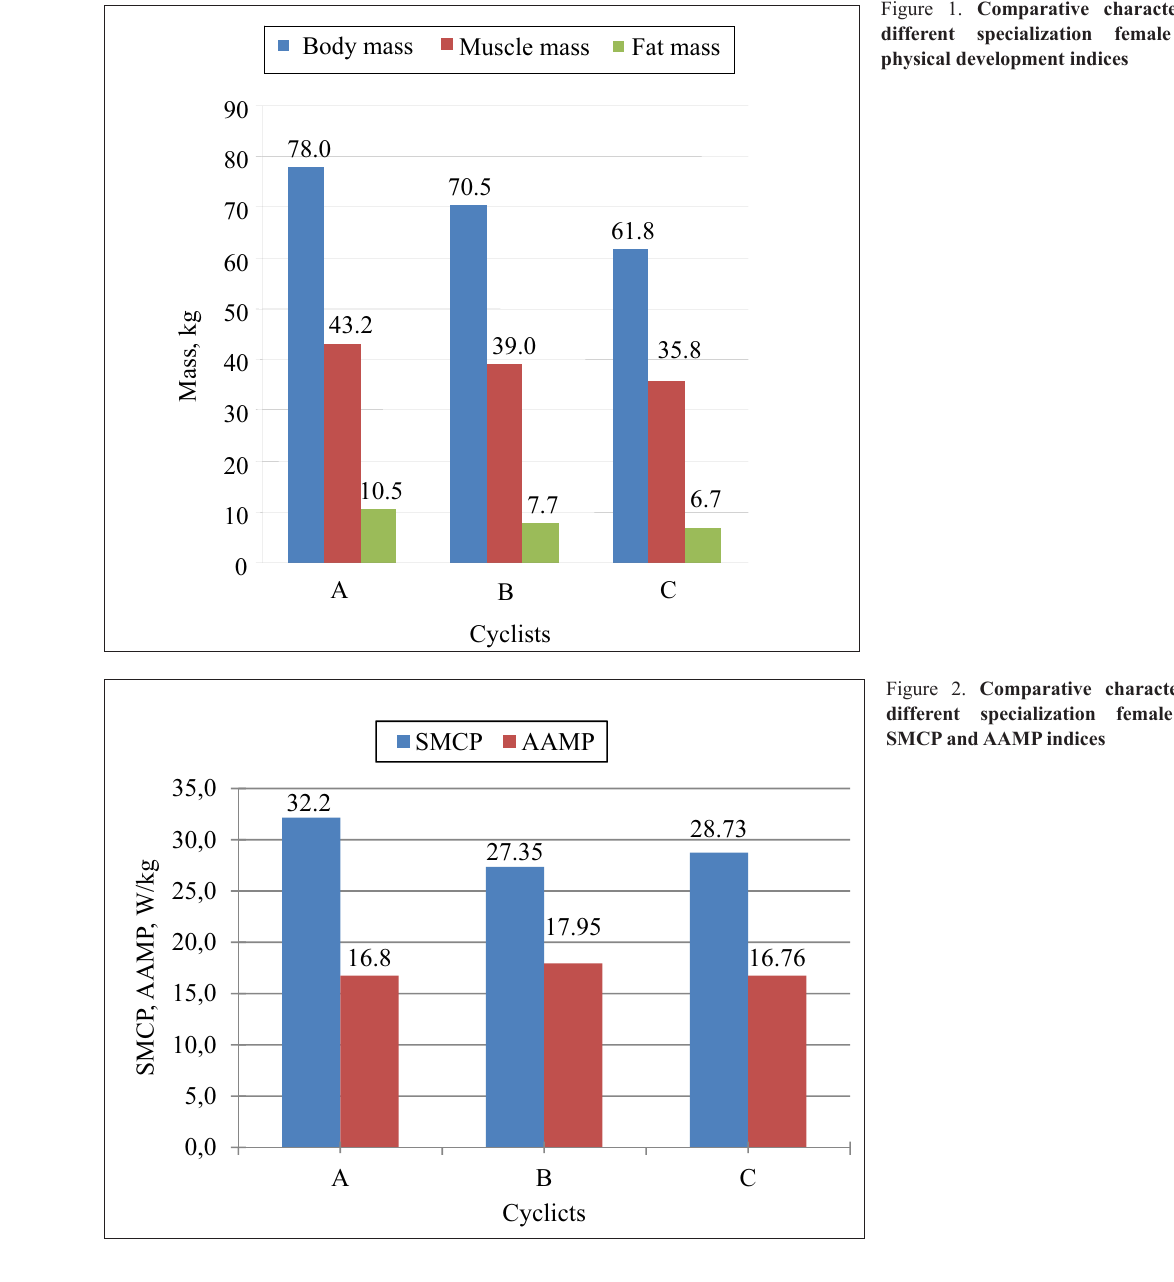
Figure 1. Comparative characteristics of different specialization female cyclists’ physical development indices